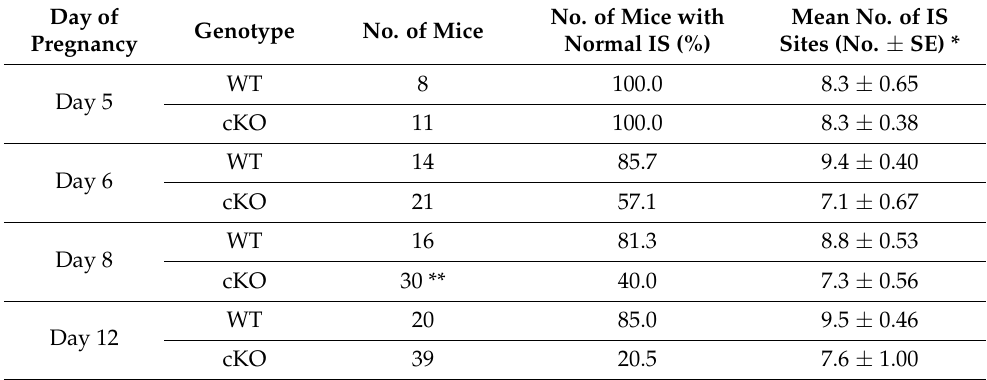
Table 1. cKO mice start to fail pregnancy maintenance after day six of pregnancy.